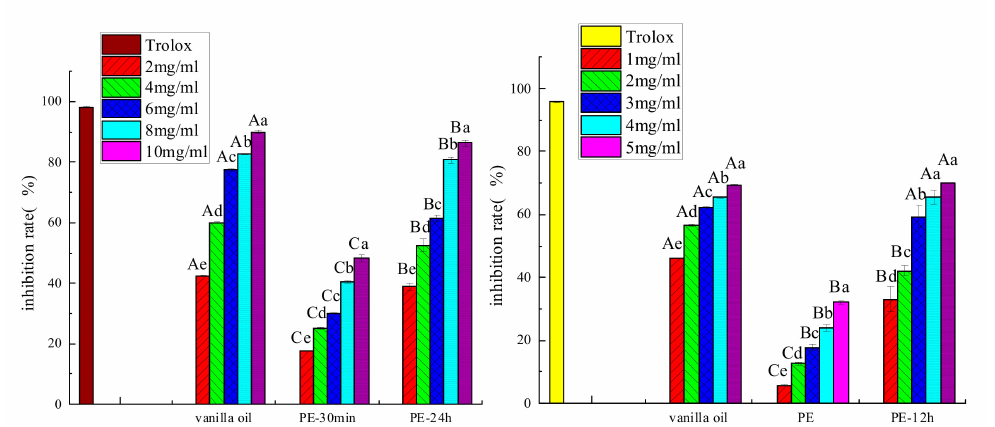
Figure 12. ( Left ) DPPH · scavenging ability and ( right ) ABTS · + scavenging ability of vanilla oil and Pickering emulsion. Note: a–e represent the difference between different concentrations in the same group, A–C represent the difference between different groups at the same concentration, and different letters represent significant differences ( p <